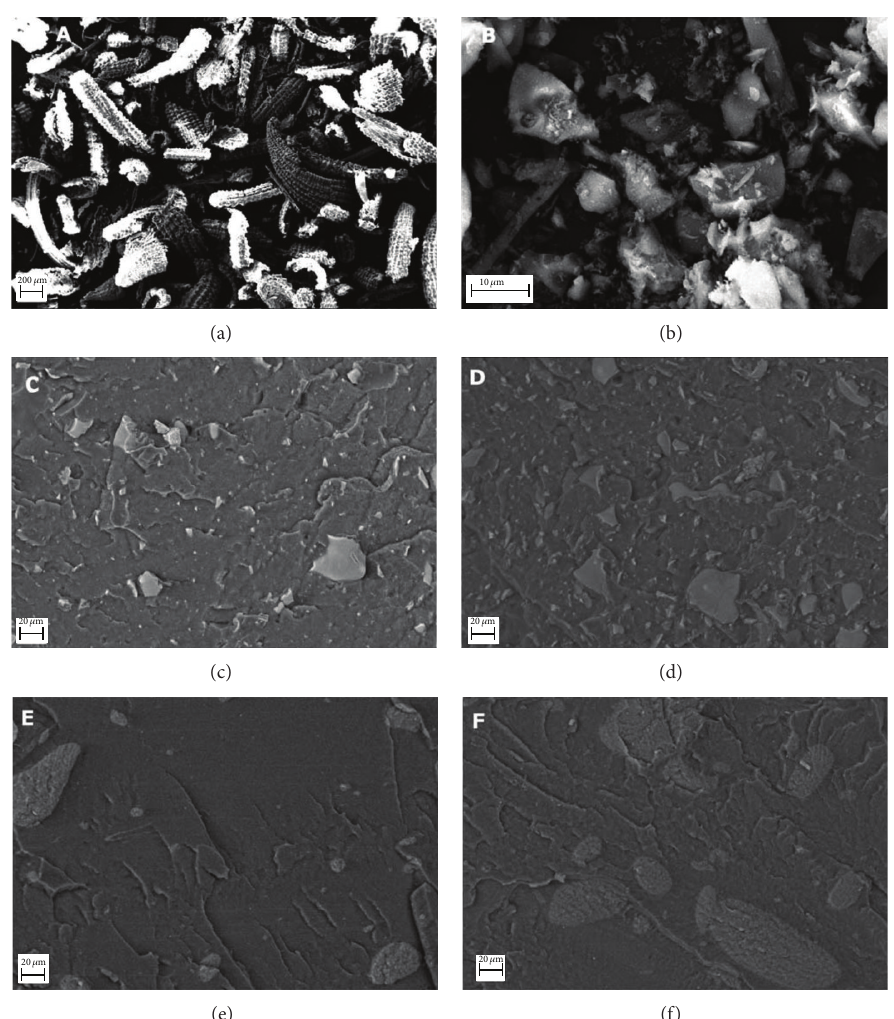
Figure 12: SEM micrographs of silica powder (a and b) and composites containing 10 and 30wt% of extracted (c and d) and of commercial silica (e and f)